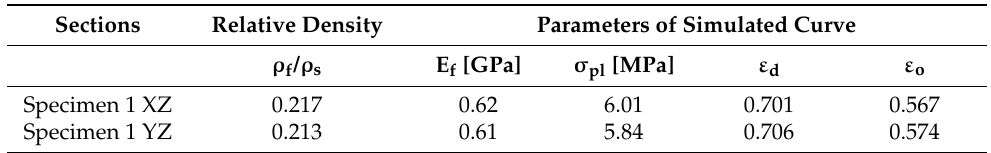
Table 4. Relative density and parameters of simulated compression curve: comparison between longitudinal sections XZ and YZ of reference Specimen 1, as defined in Figure 2.